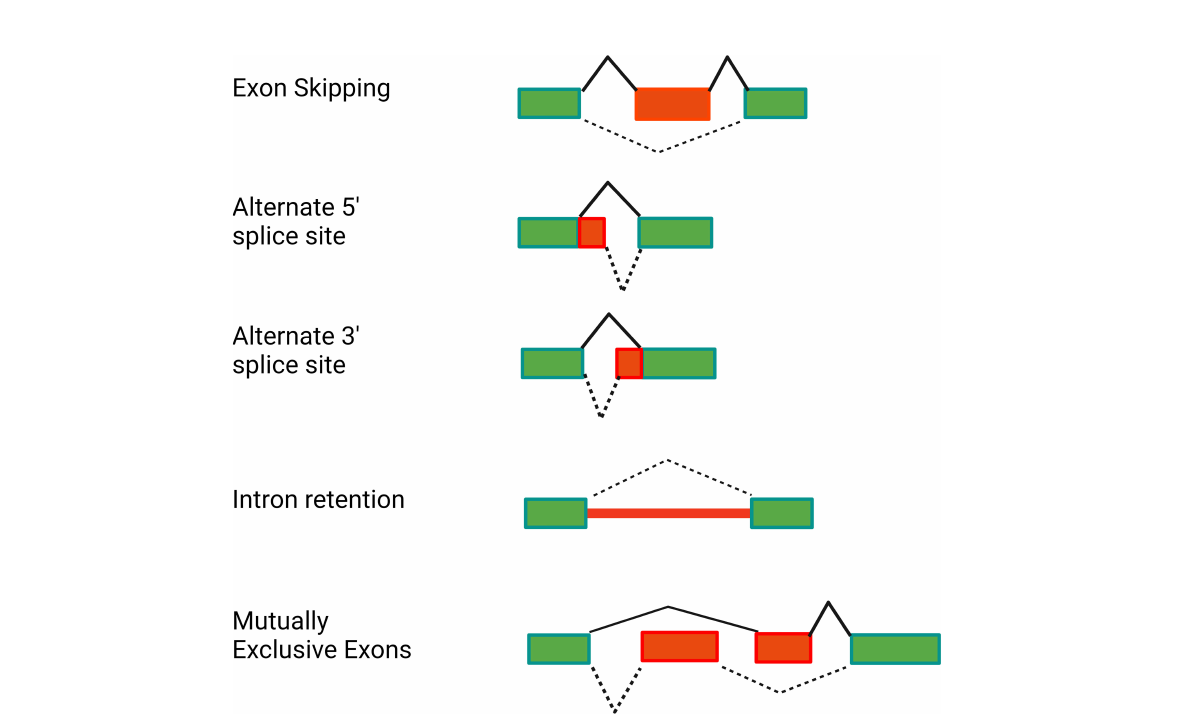
FIGURE 2 Alternative pre-mRNA splicing can generate several classes of alternative splice forms. The schematics depict different classes of alternative splicing events. Rectangles depict the exons present in the pre-mRNA. Red is used to highlight the relevant regions of the pre-mRNA that are altered in the alternative isoform. Solid black lines indicate splicing of the canonical mRNA. Dotted black lines indicate splicing of the alternative isoform. Figure created with